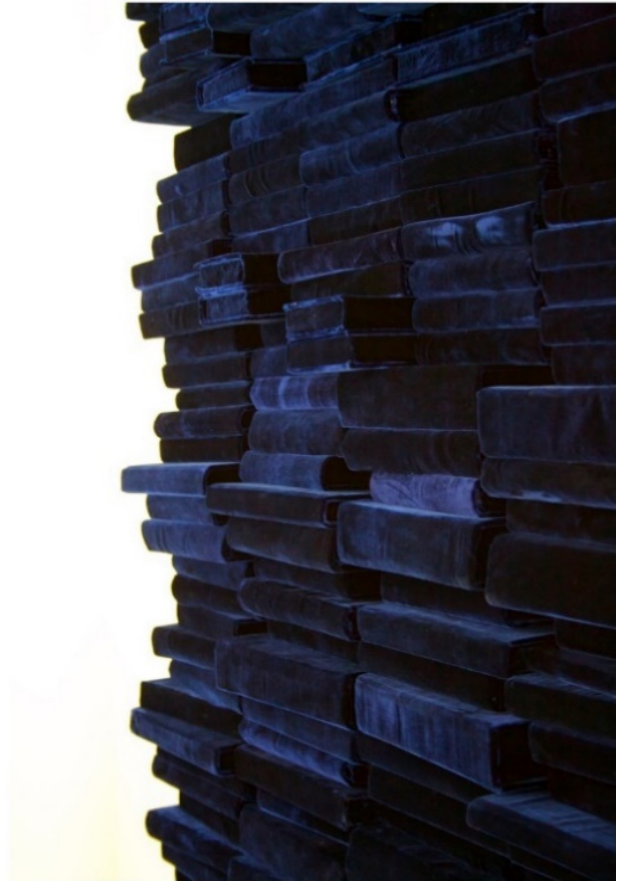
Figure 1. Velvet Books.